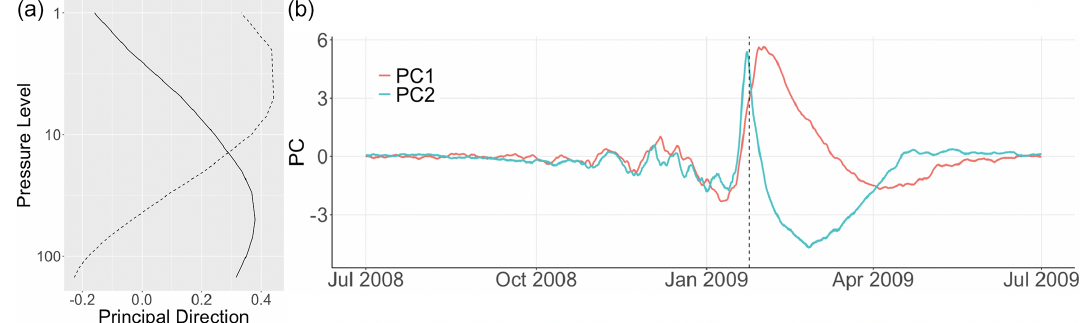
Figure 2. (a) First (solid) and second (dashed) principal direction of maximum variance obtained from a PCA on polar-cap-averaged tem- perature anomalies at pressure levels between 150 and 1hPa. Each PC explains 56% and 35% of the overall variance, respectively. (b) First (red) and second (cyan) principal components (PCs) for winter 2008/09 obtained using PCA on polar-cap-averaged temperature anomalies at levels 150, 125, 100, 70, 50, 30, 20, 10, 7, 5, 2, and 1hPa. Vertical dashed line: date of first wind reversal at 60 ◦ and